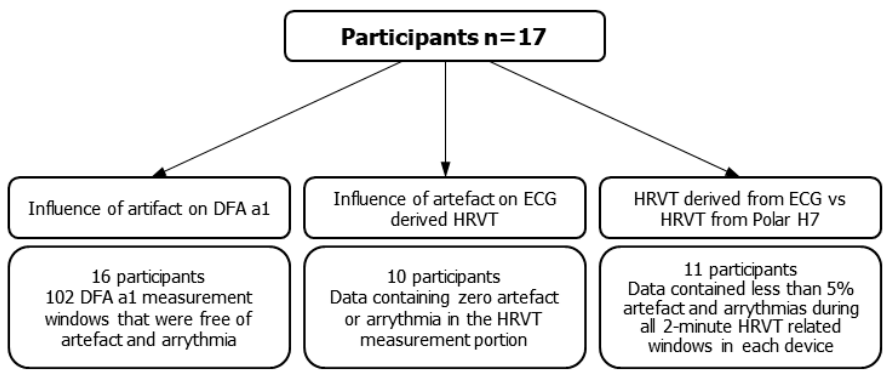
Figure 1. Inclusion criteria, numbers of included participants and data intervals for the threefold purpose of this